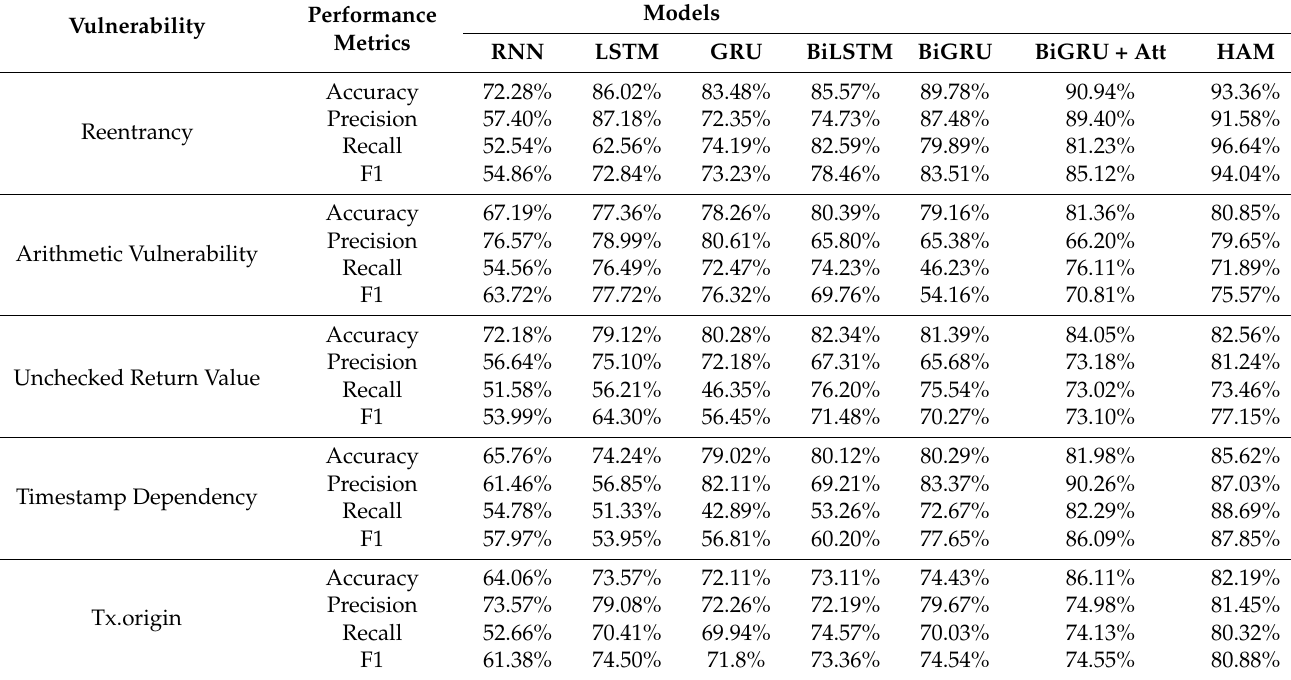
Table 5. Performance Comparison of Deep Learning Models on Code